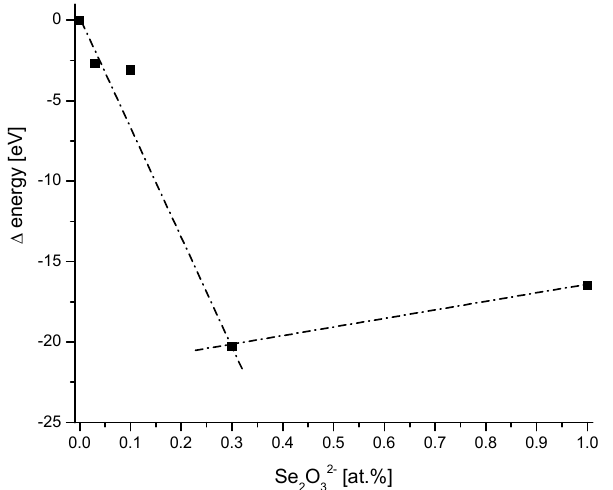
Figure 7. The involvement of Se in hydroxyapatite, data from [49]. Left side corresponds to substi- tuted hydroxyapatite, the right one to the calcium selenite hydrate.